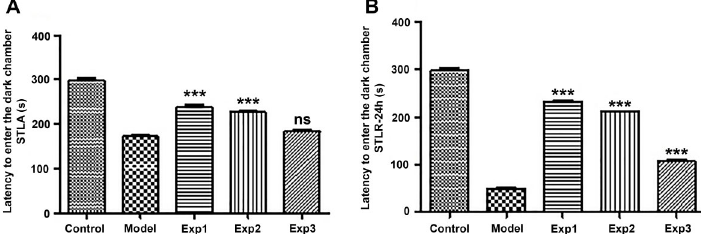
Figure 7. Effect of bilateral microinjection of insulin amyloid fi brils in the presence and absence of silibinin. A , Step-through latency in the acquisition (STLA) trial in rats of the passive avoidance test. B , Step-through latency in the retention (STLR) test after 24 h of the passive avoidance test. Data are reported as means ± SE. ***P o 0.001 compared with model group (ANOVA). ns: not signi fi cant. See Table 1 for group